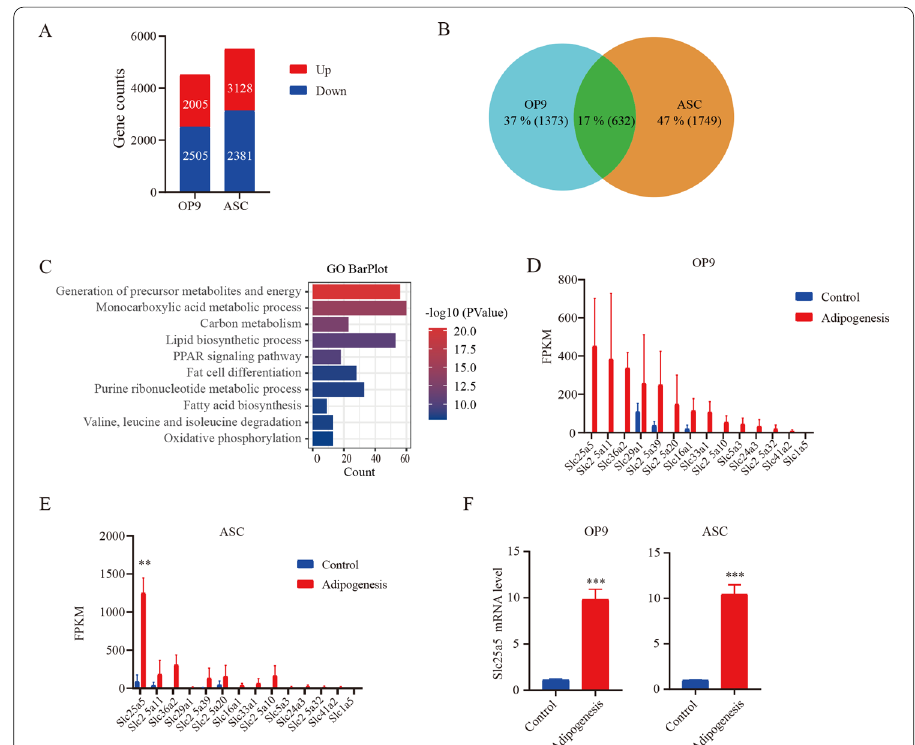
Fig. 1 Slc25a5 is increased in adipogenic differentiation. RNA-seq data were obtained from OP9 cells and ASCs undergoing adipogenic differentiation and those that were not. A Upregulated and downregulated gene expression profiles were selected. B Venn diagram illustrating the upregulated genes in both OP9 and ACSs during adipogenic differentiation. C Ten GO terms representing the most upregulated genes during adipogenic differentiation. D , E Expression profiles of the Slc25 gene family during adipogenic differentiation. F The relative mRNA level of Slc25a5 was measured with RT–qPCR. The values are mean ** P < 0.01; *** P < 0.001 versus